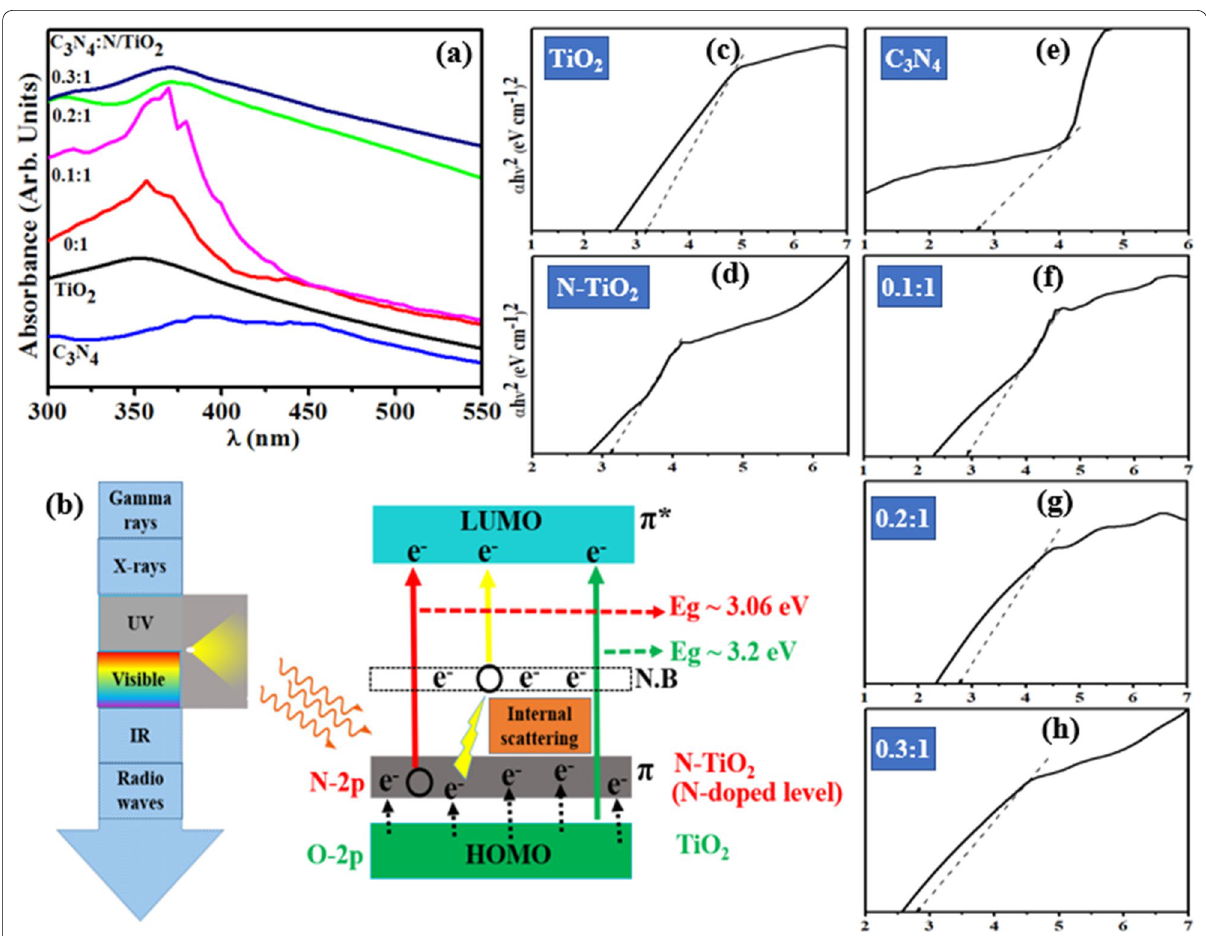
Fig. 5 a Optical absorbance spectra ( b ) possible transitions and internal scattering in UV‑vis spectroscopy ( c – h ) determination of bandgap of TiO 2 , N‑TiO 2 , C 3 N 4 , 0.1:1, 0.2:1 and 0.3:1,